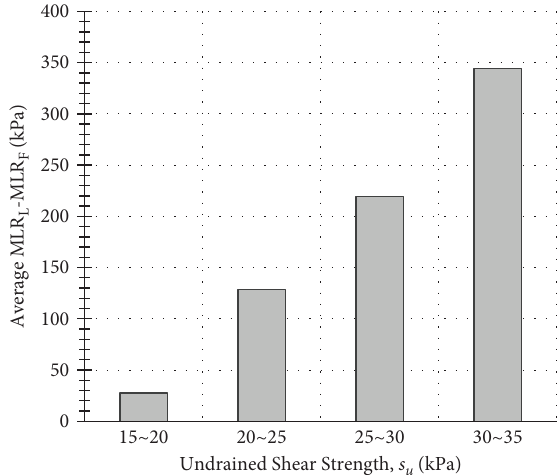
Figure 11: Diference in bearing capacity according to the load test scales.